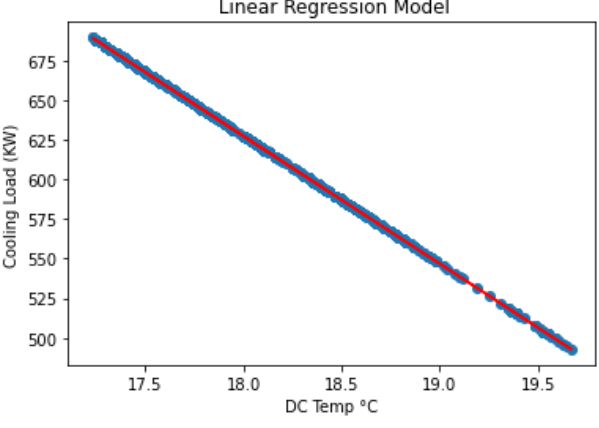
Figure 4. DC cooling load vs Temp- scatter